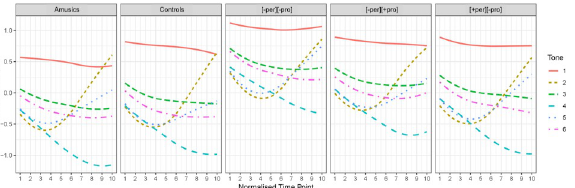
Fig 5. Normalized F0 trajectories of the six lexical tones produced by the five groups. [+per][-pro]: T2-T5; [-per] [+pro]: T4-T6; [-per][-pro]: T2-T5.